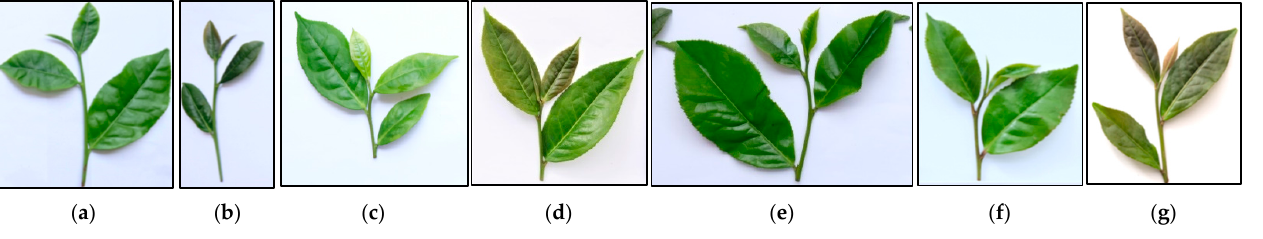
Figure 1. Shoot leaves of different tea clone-cultivars and progenies. ( a ) ‘TRI-2025 ′ ; ( b ) ‘Tambi-2 ′ ; ( c ) ‘Tambi-1 ′ × ‘Kiara-8 ′ ; ( d ) ‘Tambi-2 ′ × ‘Suka Ati-40 ′ ; ( e ) ‘Tambi-2 ′ × ‘Cinyiruan-143 ′ ; ( f ) ‘Tambi-2 ′ × ‘TRI-2025; ( g ) ‘Kiara-8 ′ × ‘Sukoi’. To explore the characteristic of catechin tea compounds in the ‘TRI-2025 ′ , ‘Tambi-2 ′ , and five hybrid progenies, we determined the contents of EGCG and C in these samples. HPLC analyses were conducted to determine the contents of EGCG and C in tea clone-cultivars and progenies (Figure 2). All standard compounds showed good linearity (R 2 > 0.99) in a relatively wide concentration range. Moreover, distinct changes in the levels of flavor-related metabolites were detected in parents and the five hybrids. Analysis of individual catechins identified that EGCG is the most abundant catechin in all leaf samples. The content of EGCG was the highest for the ‘Tambi-2 ′ × ‘Suka Ati-40 ′ (53.302 mg/g), and it was not significantly different from ‘Kiara-8 ′ × ‘Sukoi’ (52.014 mg/g) and ‘Tambi-2 ′ × ‘TRI-2025 ′ (51.456 mg/g). ‘Tambi-2 ′ had lower EGCG content (50.703 mg/g), which was not significantly different from ‘Tambi-2 ′ × ‘Cinyiruan-143 ′ (49.466 mg/g), while ‘TRI-2025 ′ (46.365 mg/g) and ‘Tambi-1 ′ × ‘Kiara-8 ′ (44.667 mg/g) had the lowest EGCG content. The content of C in ‘Kiara-8 ′ × ‘Sukoi’ was the highest (1.34 mg/g), and it was not significantly different from ‘Tambi-2 ′ × ‘Suka Ati-40 ′ (1.21 mg/g), ‘Tambi-2 ′ × ‘TRI-2025 ′ (1.19 mg/g), and ‘Tambi-2 ′ (0.99 mg/g). ‘Tambi-1 ′ × ‘Kiara-8 ′ (0.67 mg/g) had the lowest C content (Figure 2).